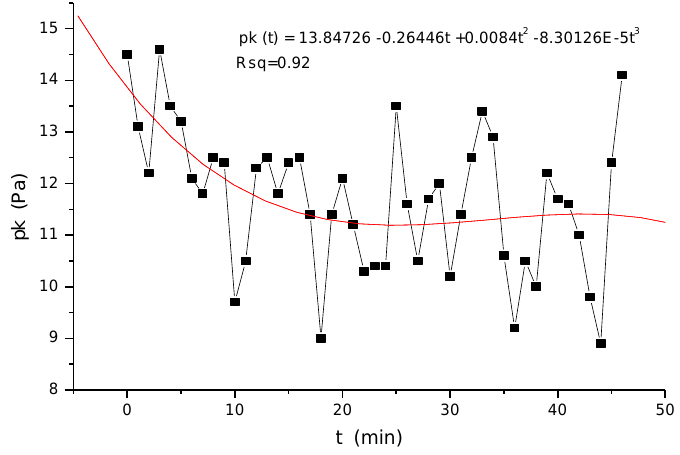
Figure 17. Dependence of pk on operating time.